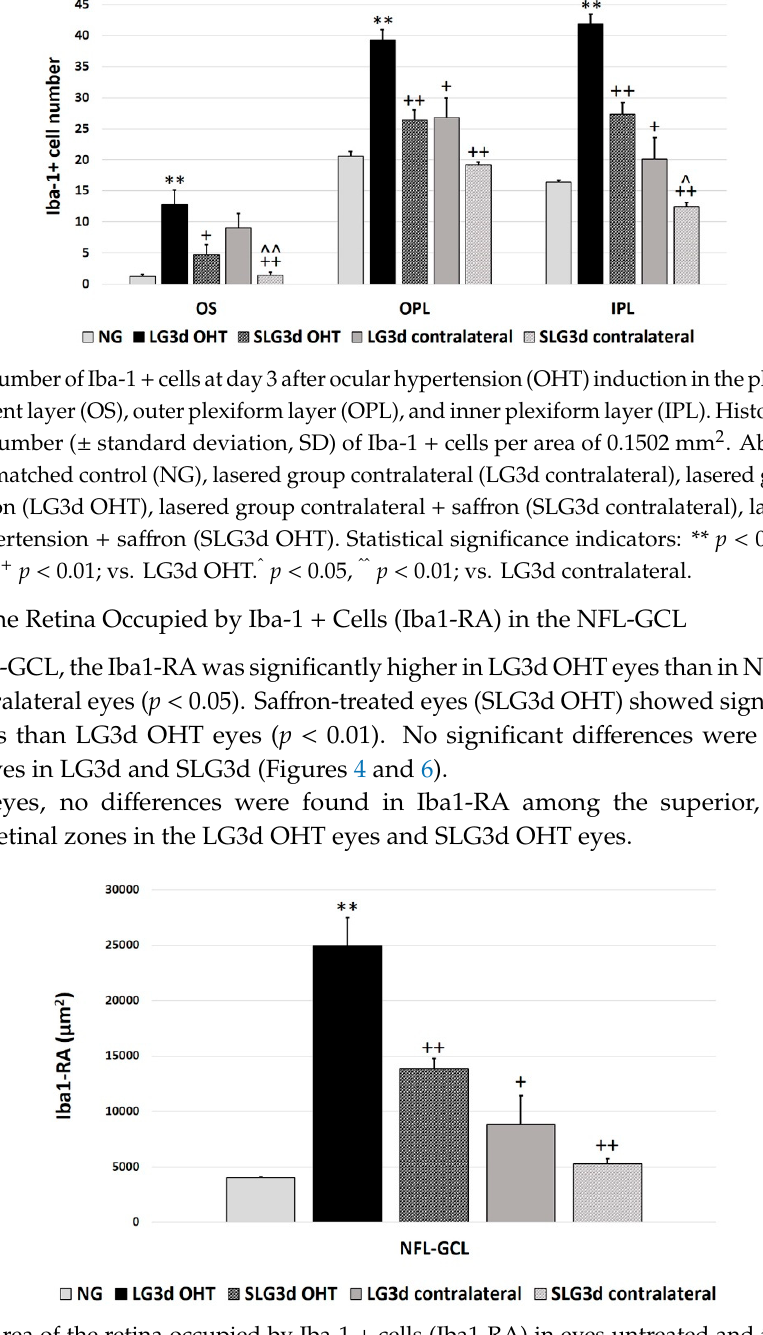
Figure 6. Area of the retina occupied by Iba-1 + cells (Iba1-RA) in eyes untreated and treated with saffron extract at day 3 after ocular hypertension (OHT) induction in the the nerve fiber—ganglion cell layer (NFL-GCL). Histograms show the mean (± standard deviation, SD) of Iba1-RA per area of 0.1502 mm 2 . Abbreviations: Naïve age-matched control (NG), lasered group contralateral (LG3d contralateral), lasered group ocular hypertension (LG3d OHT), lasered group contralateral + saffron (SLG3d contralateral), lasered group ocular hypertension + saffron (SLG3d OHT). Statistical significance indicators: ** p < 0.01; vs. NG. + p < 0.05, ++ p < 0.01; vs. LG3d OHT.